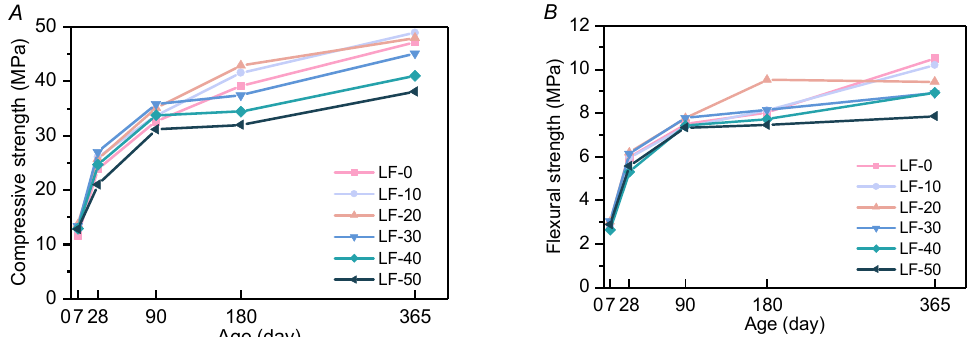
Figure 1. Compressive and flexural strength of all samples at 7/28/90/180/365 days. ( A ) Compressive strength; ( B ) flexural strength.